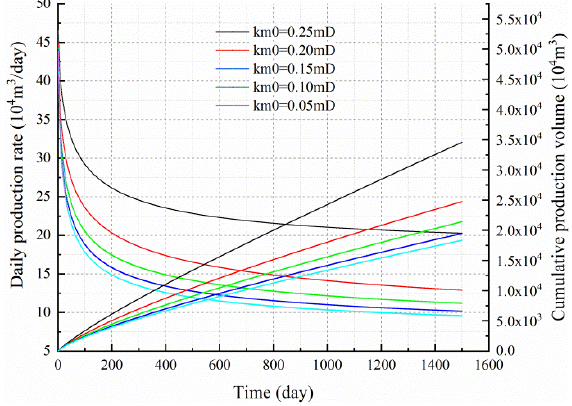
Figure 11. The e ff ect of di ff erent matrix permeability on productivity. Figure 11. The effect of different matrix permeability on productivity. Figure 11. The effect of different matrix permeability on productivity.